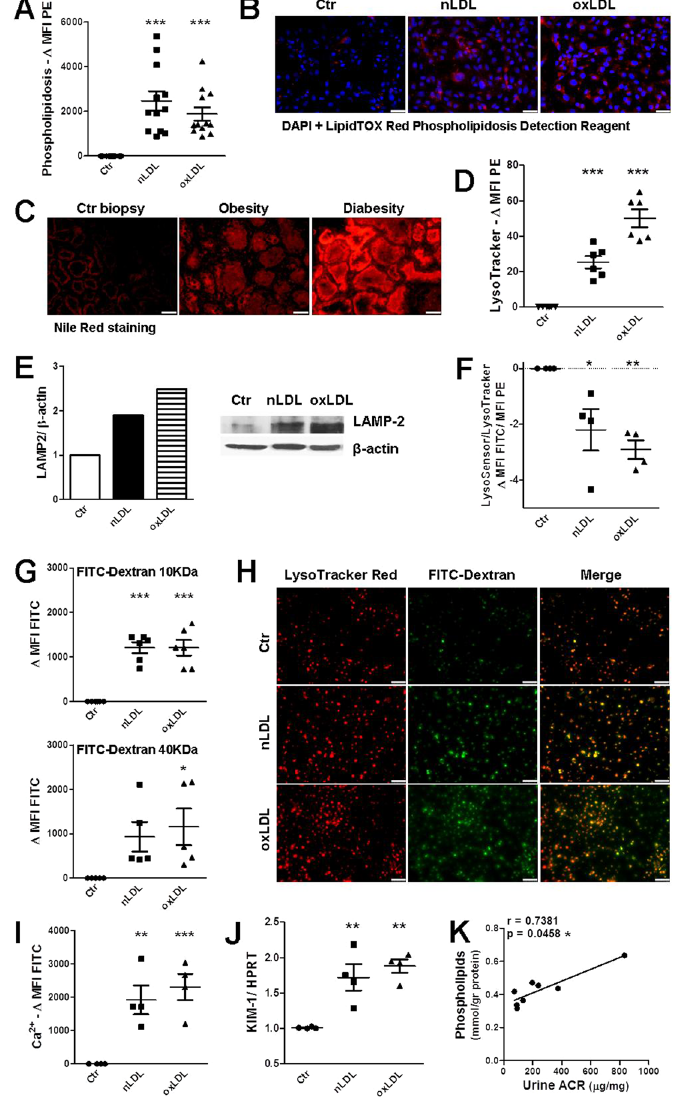
Figure 1. Lysosomal alterations induced by n/oxLDL loading in tubular cells. ( A , B ) Endolysosomal phospholipid accumulation detected by HSC LipidTox Red Phospholipidosis Detection Reagent at day 3. ( A ) Rise in phospholipidosis in HK2 tubular cells as compared to control (Ctr) (FC). MFIs of controls subtracted from the MFIs of n/oxLDL-treated cells. ( B ) Fluorescence microscopy images of control and LDL-loaded HK2 tubular cells to visualize phospholipidosis (red) and nuclei (blue, DAPI). Scale bar, 50 µ m. ( C ) Nile Red staining of human frozen renal sections from individuals with no metabolic disorders, obesity with hyperlipidemia or with diabetes. Background staining digitally subtracted. Scale bar, 50 µ m. ( D – F ) Lysosomal alterations upon n/oxLDL exposure for 3 days. ( D ) FC analysis of the PE fluorescence intensity emitted by LysoTracker Red- labelled endolysosomes in alive HK2 cells. MFIs normalized to controls by subtraction. ( E ) Western blot for LAMP-2 using HK2 cells lysates. Intensity normalized to β -actin loading control. Protein expression shown as fold increase compared to control equal to 1. ( F ) Changes in lysosomal acidity detected by pH-dependent LysoSensor Green probe. Dotplots showing FITC intensity in relation to the PE intensity of LysoTracker Red stained lysosomes (FC). ( G ) FC analysis of HK2 cells exposed to FITC-Dextran 10/40 KDa for 90 min after 3 days treatment with LPDS or n/oxLDL. Control group MFIs subtracted from MFIs of n/oxLDL groups. (H) 40 KDa FITC-Dextran (green) leakage from the lysosomes (red) of 3 days treated HK2 cells. Scale bar, 50 µ m. (I) Cytoplasmic calcium detected by the Fluo-4-AM Ca 2 + indicator (FC). Differences in FITC MFIs. ( J ) QPCR analysis for KIM-1 gene expression normalized for HPRT, relative to control. ( K ) Spearman rank correlation between urinary albumin to creatinine ratio (ACR, µ g/mg) and renal phospholipid content (mmol/ gr protein). WT mice fed a control or Western-diet; n = 8. ( A,B,D – J ) All assays performed after 3 days loading. Dots representing averages of independent experiments. Data shown as mean ± SEM; * P < 0.05, ** P < 0.01, *** P <